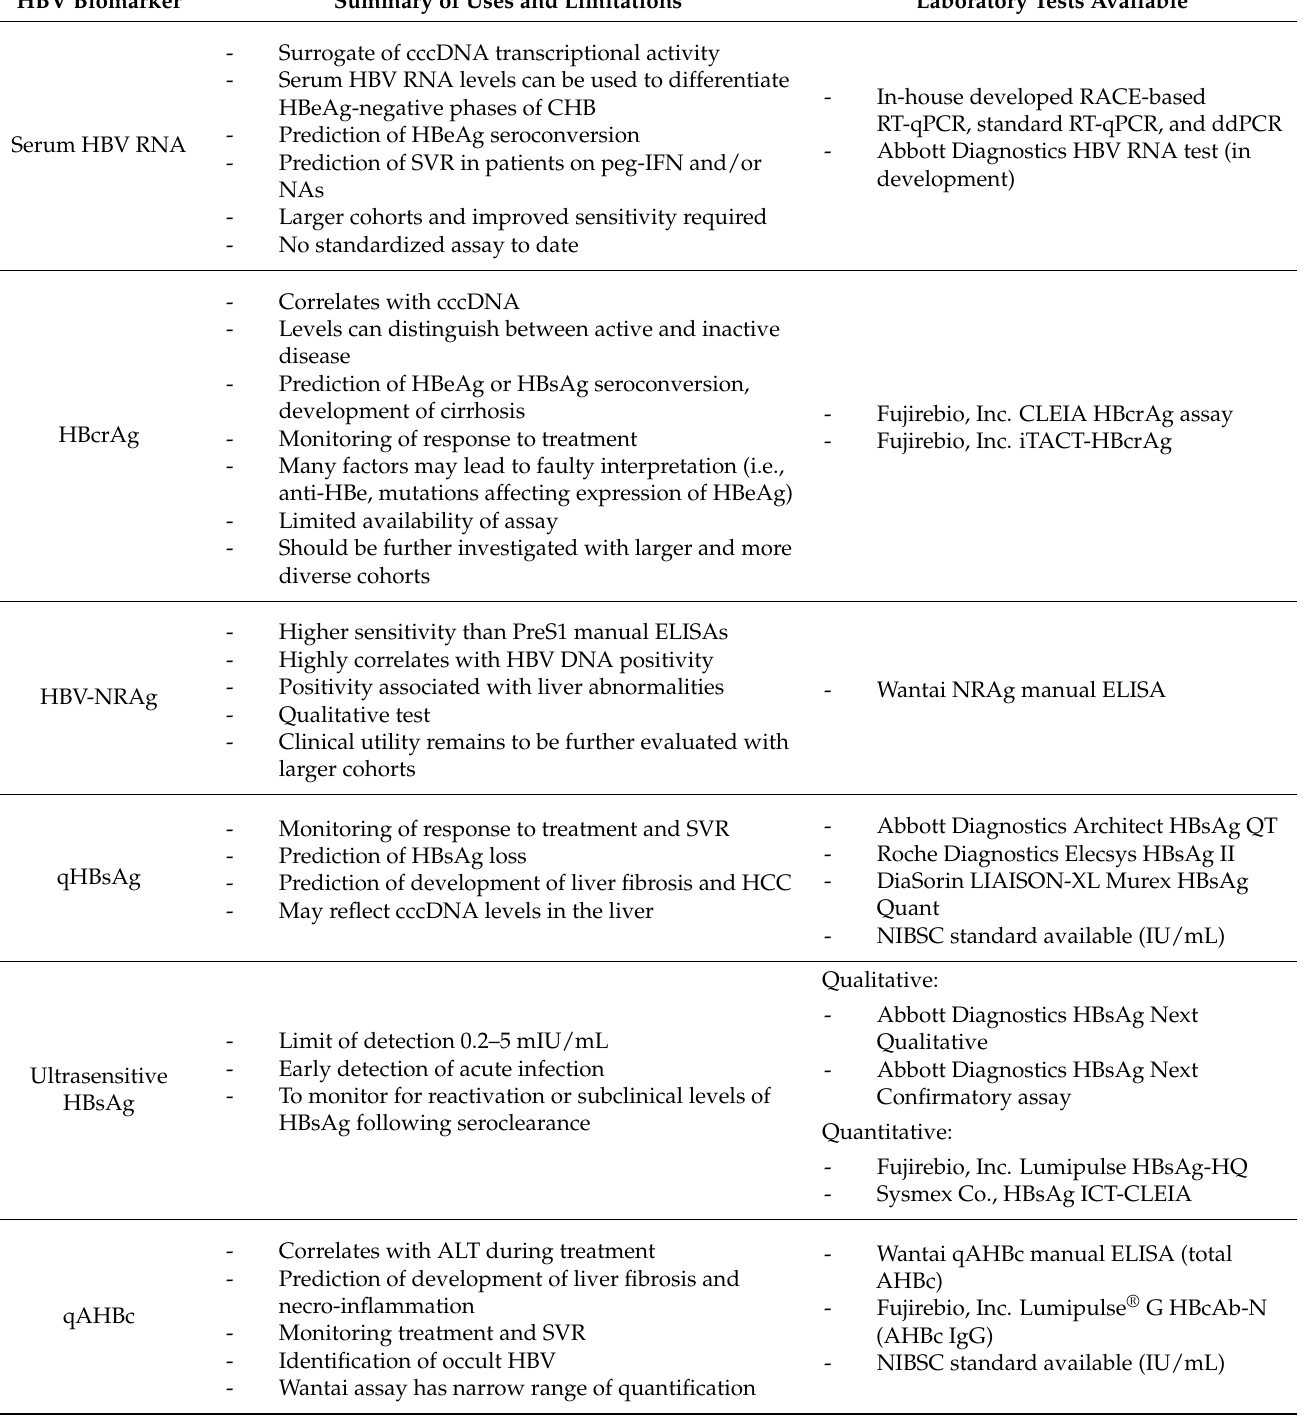
Table 1. Summary of Novel HBV Biomarkers and Available Laboratory Tests. HBV